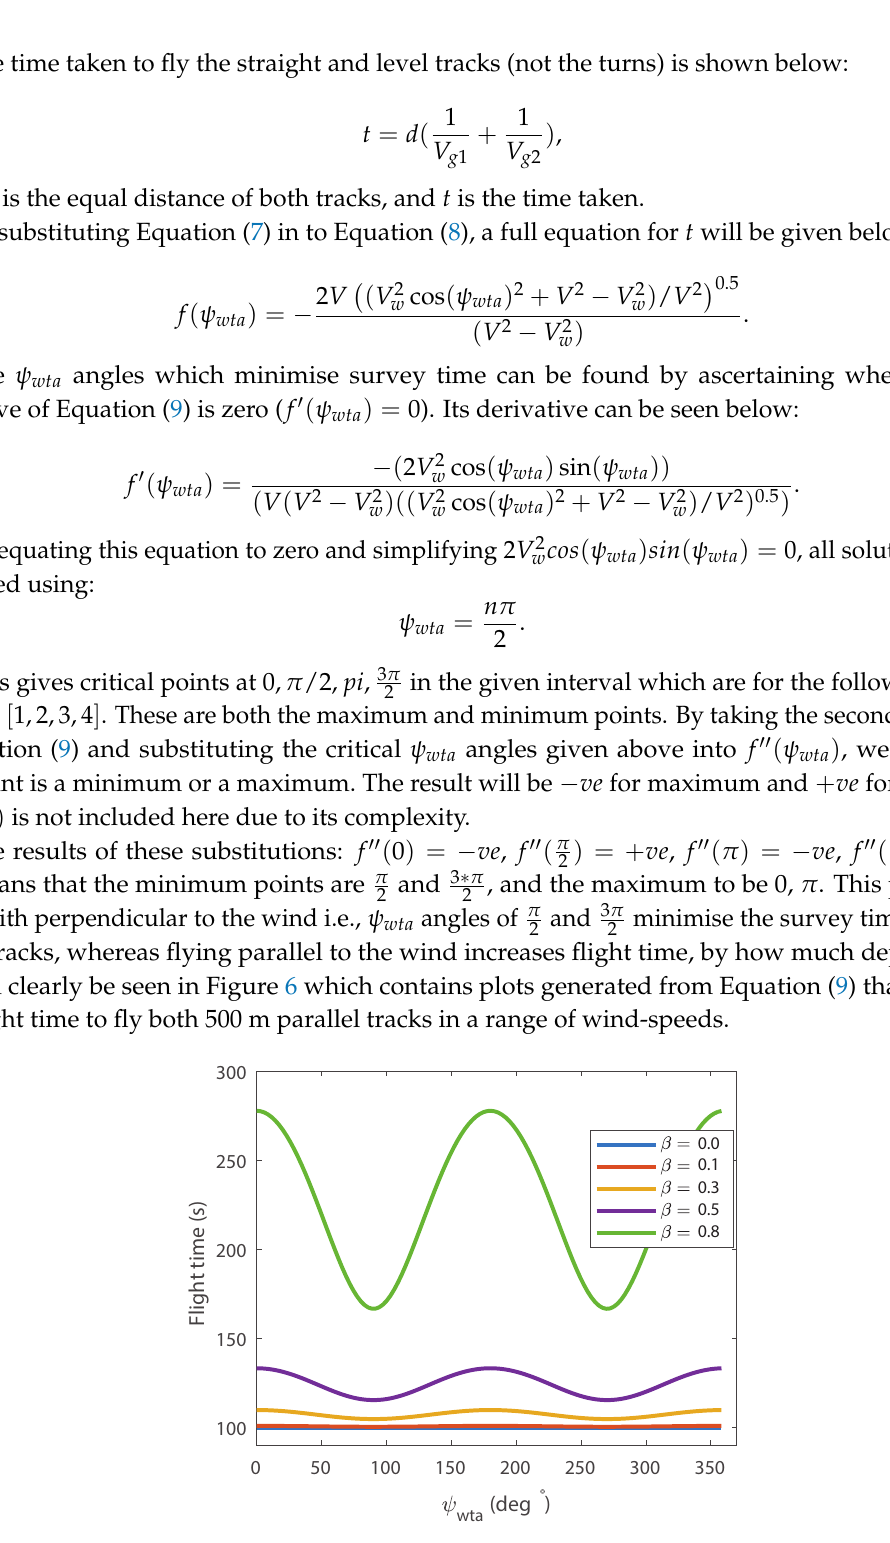
Figure 6. Total flight time for the portion of the flight along two parallel 500 m tracks as defined in Figure 5 for a range of wind/airspeed